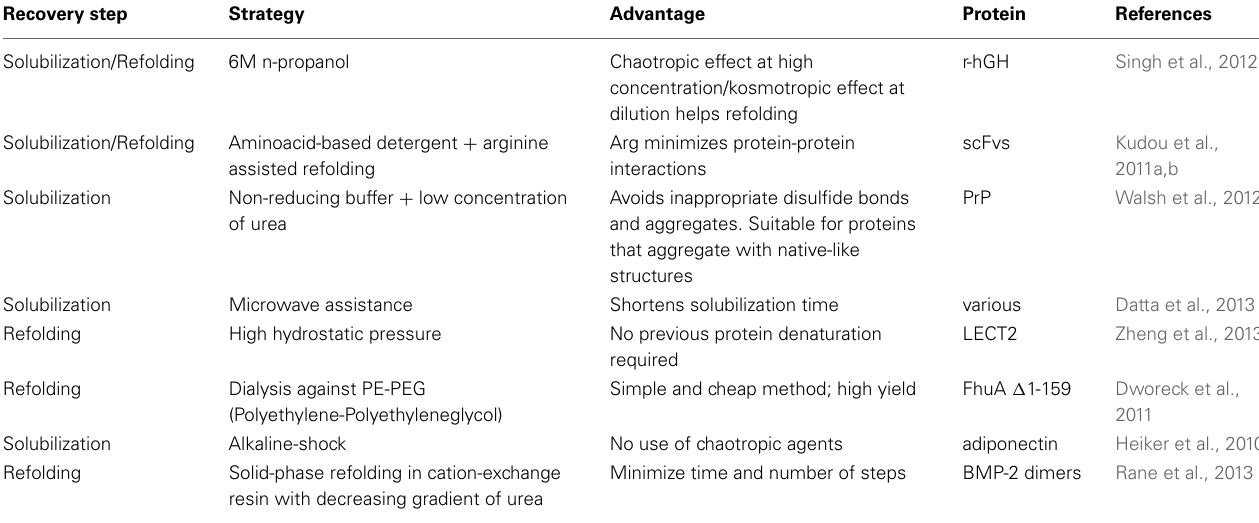
Table 1 | Novel approaches employed in the recovery of proteins from